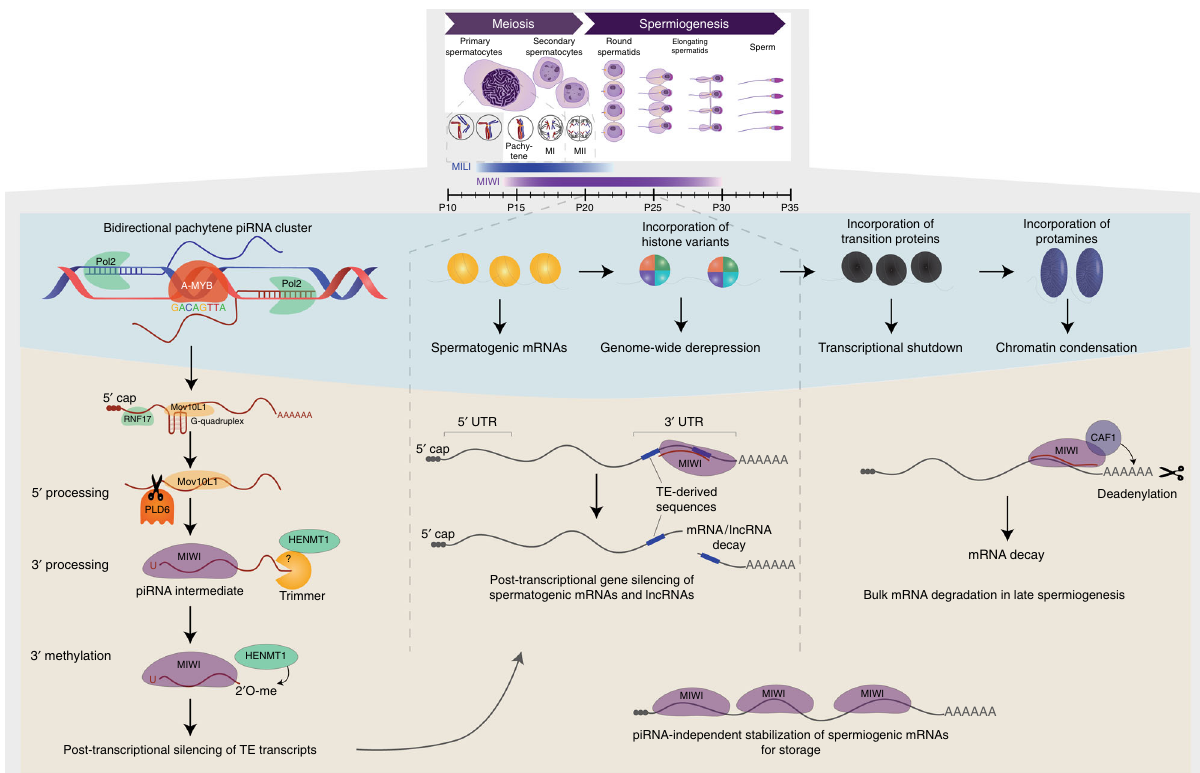
Fig. 3 Multiple roles of action for pachytene piRNAs during mouse spermatogenesis. Pachytene piRNA expression starts during prophase of the fi rst meiotic division when spermatocytes reach the pachytene stage. This expression is orchestrated by the transcription factor A-MYB, which drives expression of piRNA clusters and other piRNA pathway-related genes. Pachytene piRNAs are transcribed from distinct clusters in the genome often carrying bidirectional promoters. piRNA precursors are then processed in the same fashion as pre-pachytene piRNAs and mature pachytene